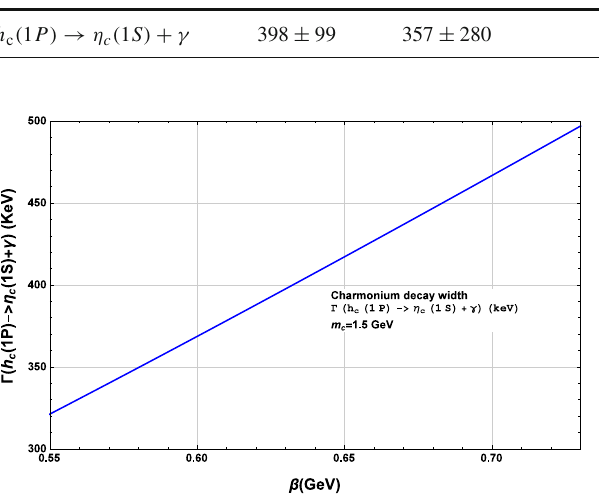
Fig. 2 Decay width for h c ( 1 P ) → η c ( 1 S ) + γ (keV) as a function of β